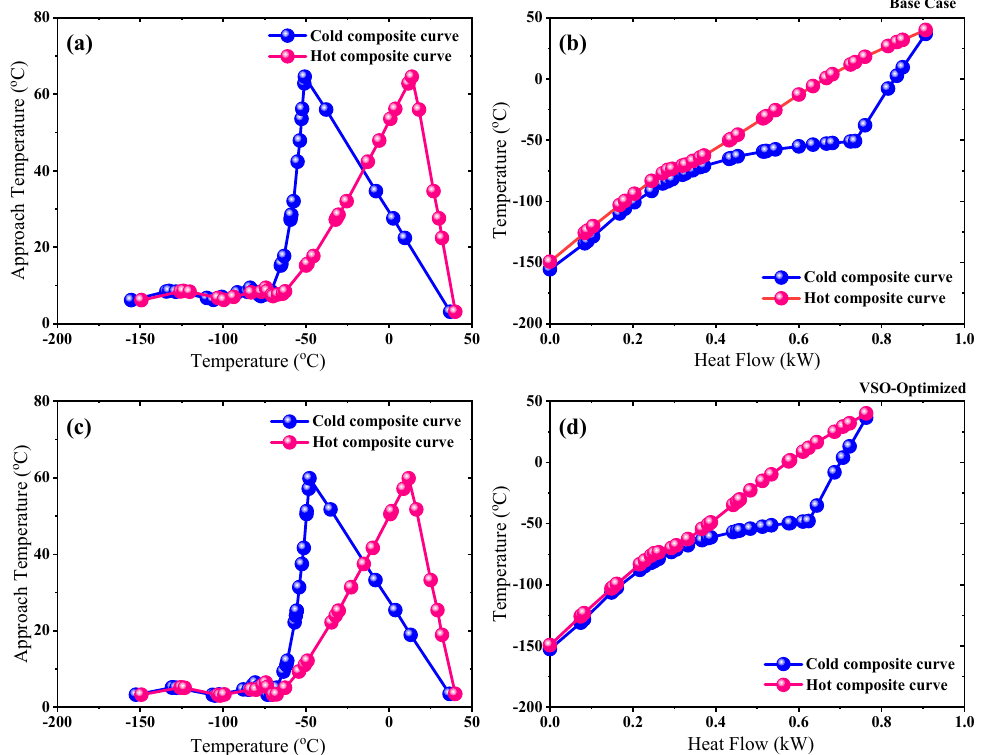
Figure 6. Base case (a) temperature difference composite curve (TDCC) and (b) temperature-heat flow composite curve (THCC) in comparison with the VS-optimized (c) TDCC and (d) THCC curves of the SMR process.